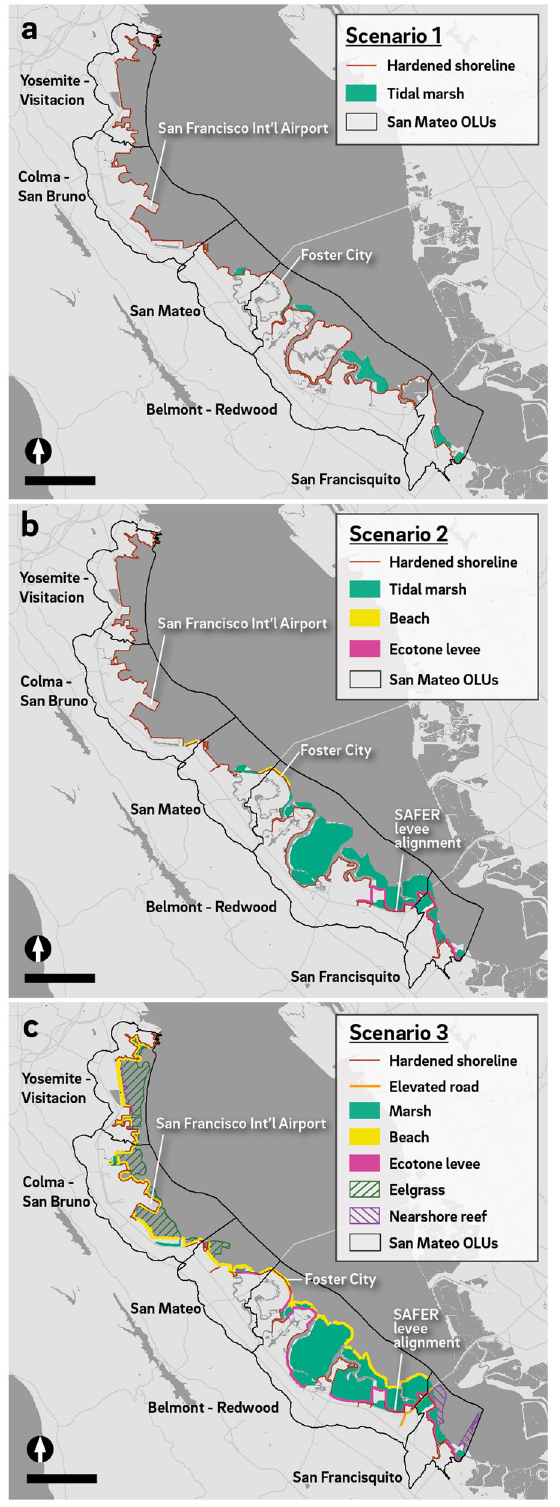
Fig. 5 Three scenarios of adaptation across the fi ve OLUs of San Mateo County. Scenario 1 represents an engineered shoreline, or ‘ What we might have done. ’ This scenario serves as a baseline or comparison for the other two. Scenario 2 represents currently planned or permitted conservation and restoration projects, or ‘ What we are doing. ’ Scenario 3 uses information from our suitability assessment to include additional nature-based features, or ‘ What we could do next. ’ Black scale bars represent 5